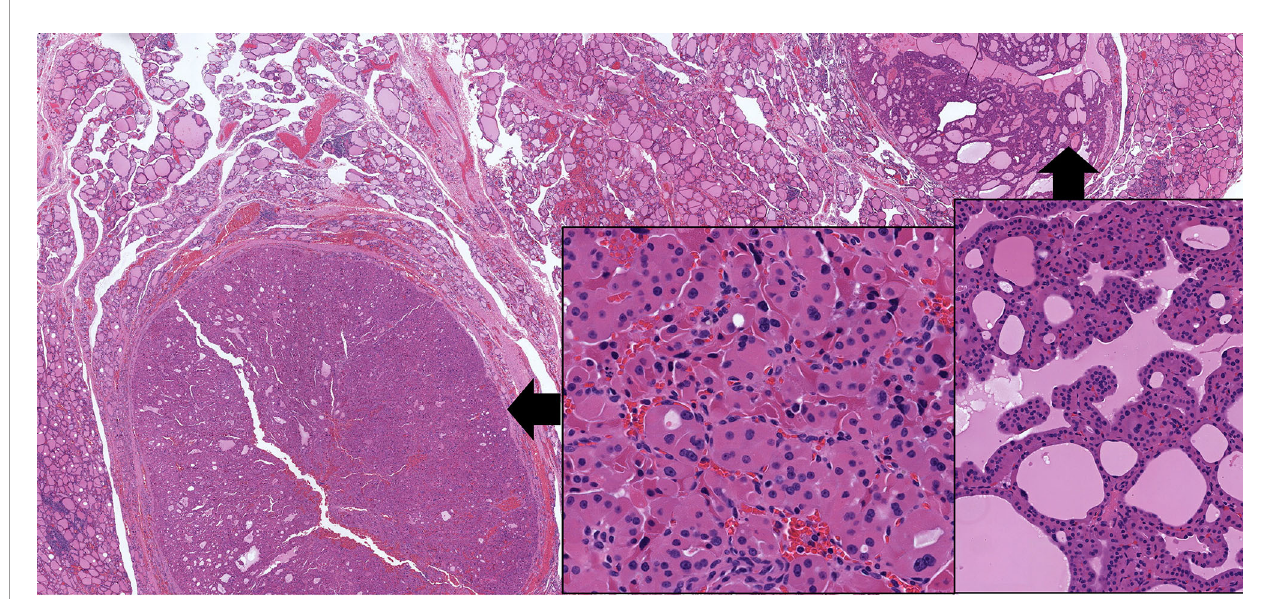
FIGURE 3 | Oncocytic Change in Follicular Nodular Disease of Thyroid. Multifocal benign proliferations of thyroid follicular epithelium have variable architecture and cytology. In some instances, they can exhibit focal or diffuse oncocytic change; in this example, the gland has two adjacent lesions, one with follicular architecture (left) and one with papillary architecture (right), both showing extensive oncocytic cytology (insets) but retaining the uniform, round and homogenous nuclear morphology of benign thyroid follicular